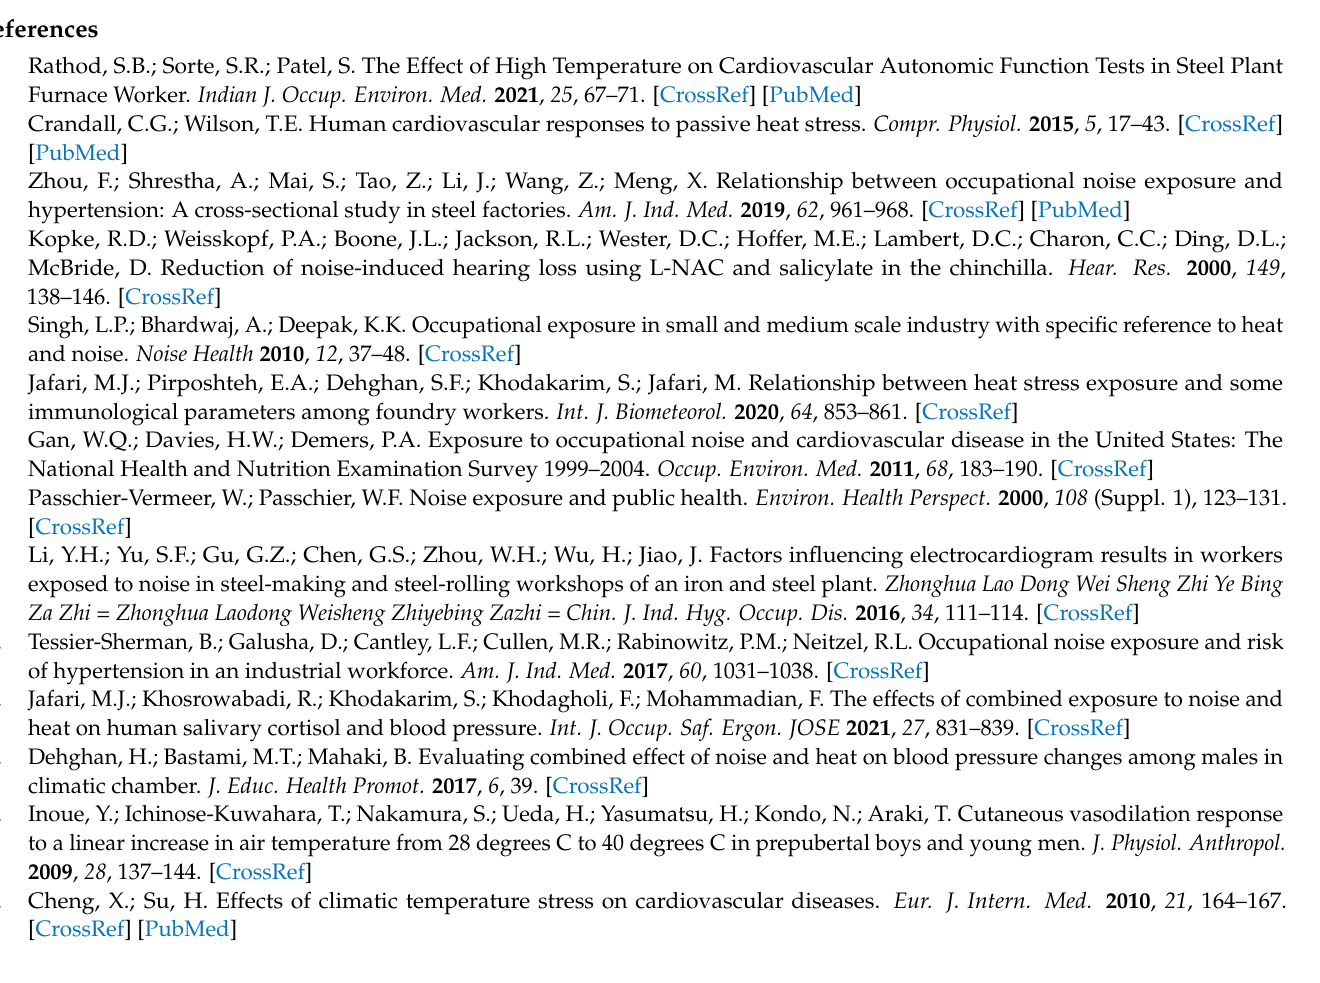
Table S2: Basic characteristics of participants according to occupational exposure status, Table S3: Inter- actions between occupational heat stress and noise on odds of carotid plaque, Tables S4–S6: Multivariate adjusted ORs between carotid plaque and different occupational exposure